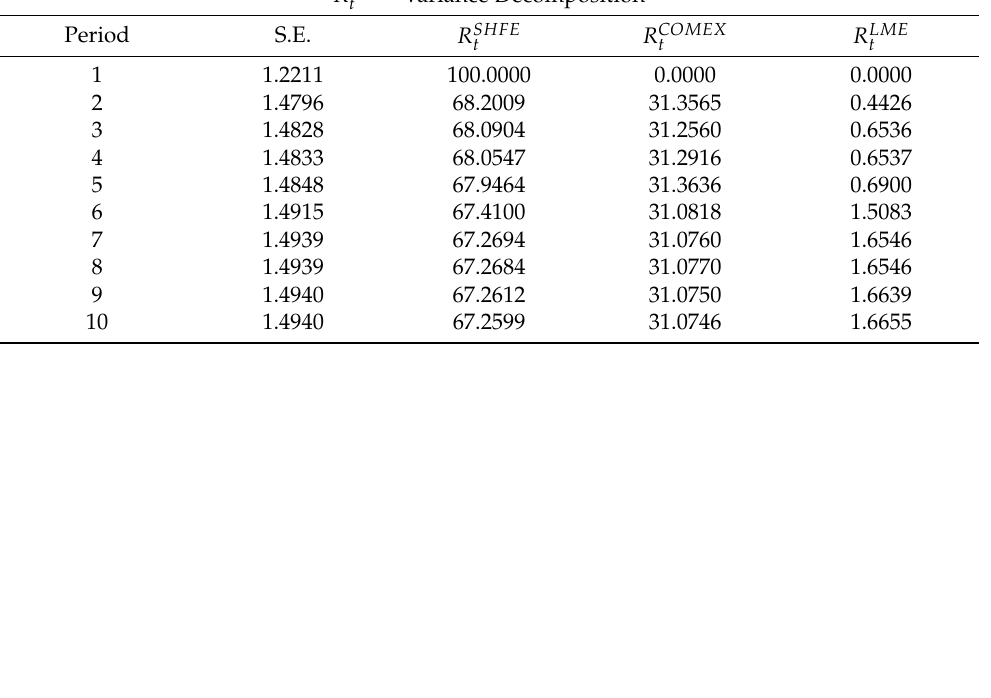
Figure 6. Impulse response of SHFE to LME copper yield.